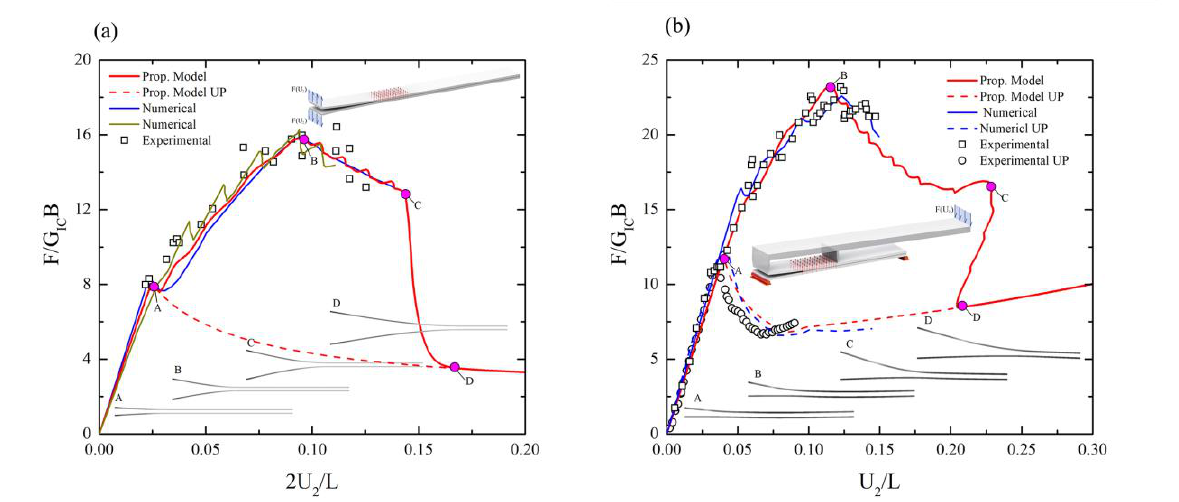
Fig. 7. Investigation on Z-pins contributions: Comparisons in terms of loading curve with experimental data and numerical results for DCB test (a) and MMB test